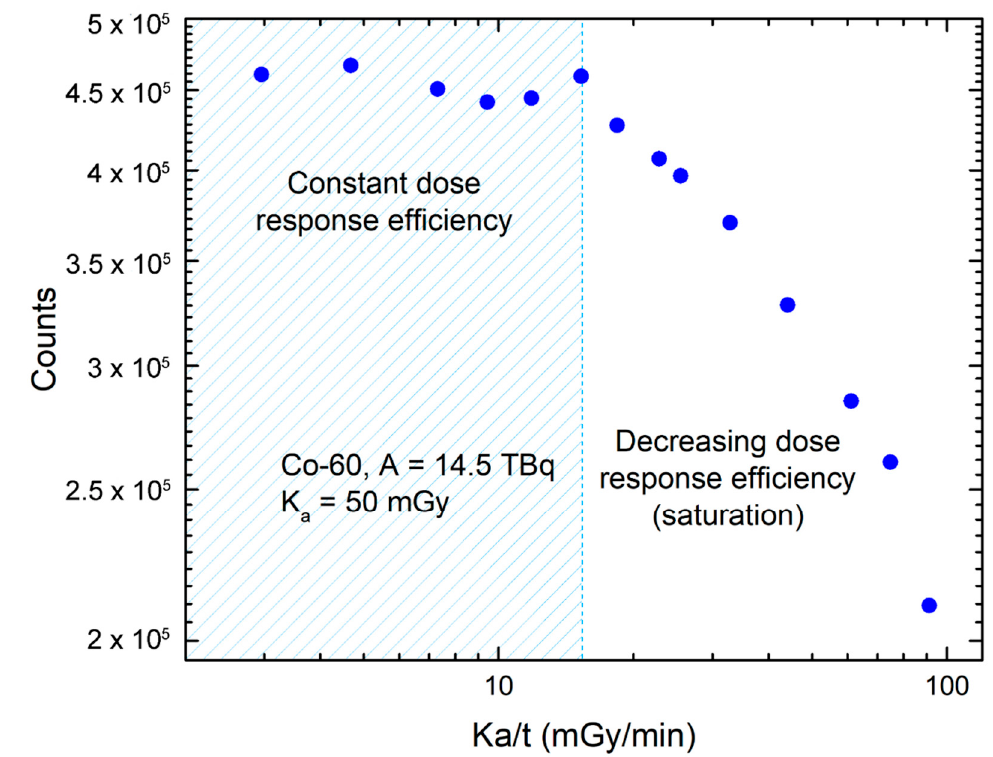
Figure 9. Response of 4H-SiC detector with active surface area of 2 × 2 mm 2 to Co-60 source with activity of 14.5 TBq. Irradiations with were performed with different air kerma rates.